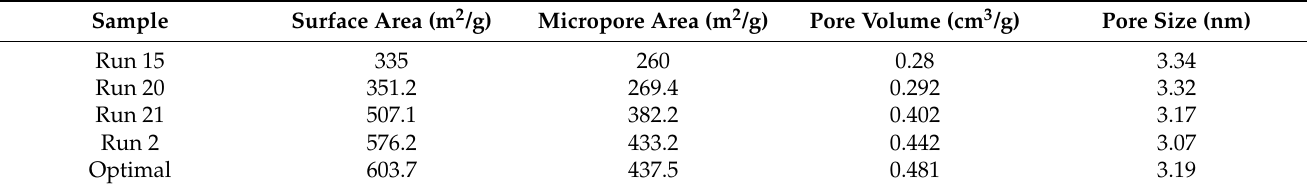
Figure 4. The nitrogen adsorption and desorption curves of the above five materials. ( a ) adsorption and desorption curves of each material; ( b ) the pore size distribution of the materials. Table 6. The analysis of the specific surface area and pore fraction of the